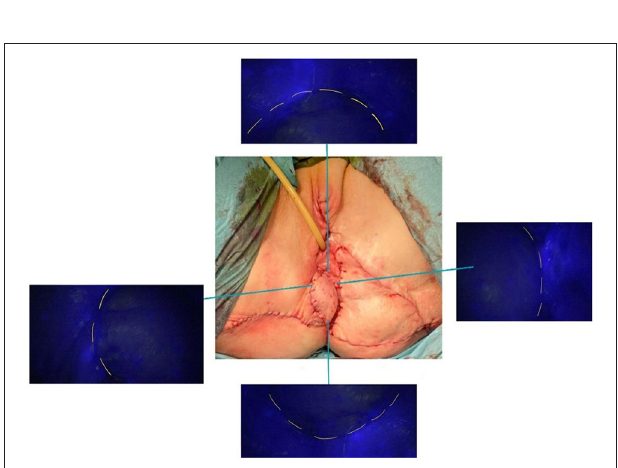
FIGURE 3 | Combined V-Y and lotus petal flap with intraoperative dye